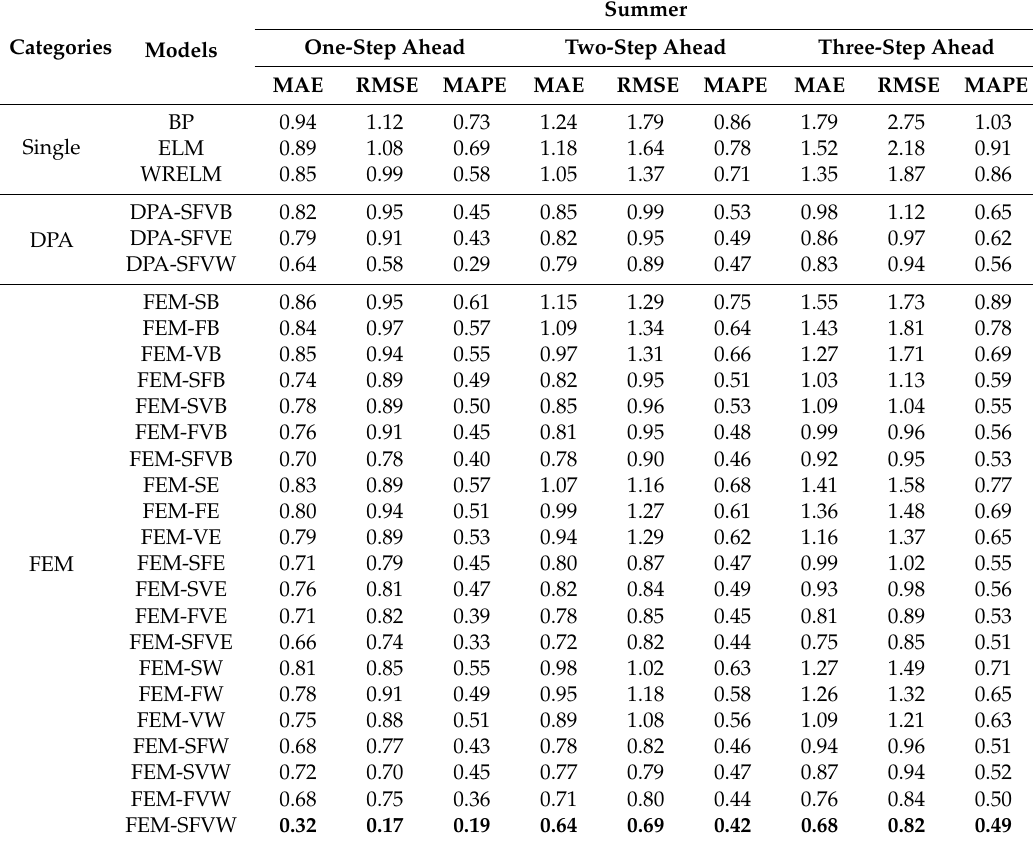
Table 7. Comparison of prediction performances of different models in